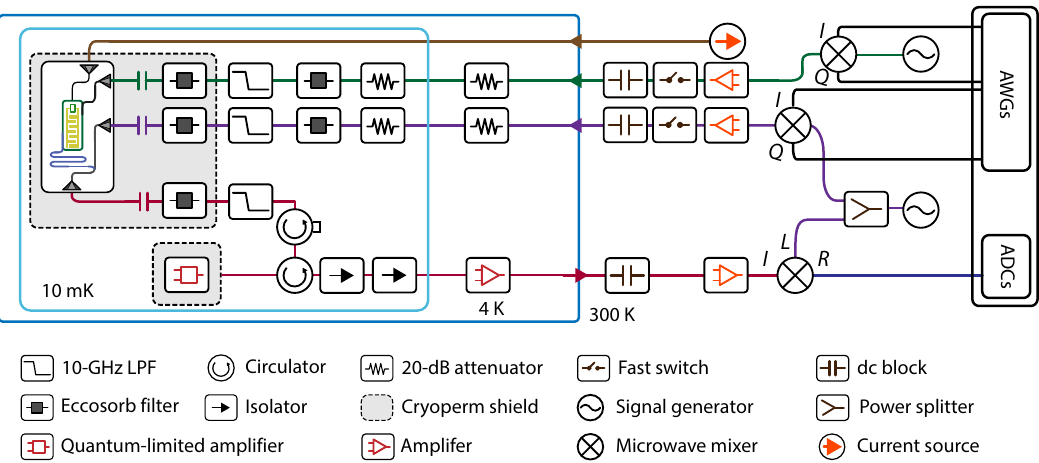
FIG. 8. A typical microwave signal processing chain for a flux-tunable transmon coupled to a readout resonator. The input lines (green and purple) to the sample are usually wired with 20-dB cryogenic attenuators at both the 4-K and 20-mK stage. This level of attenuation, together with the intrinsic insertion loss incurred along the coaxial cables, ensures that the thermal photons reaching the device are kept below 10 − 3 . Commercial low-pass filters (LPFs) and custom-made Eccosorb filters [144,145] are also introduced to suppress high-frequency noise. The output signal passes through a single Eccosorb filter, located inside the Cryoperm, and a low-loss filter. This typically incurs a < 2 dB insertion loss on the signal, which then travels through two cryogenic circulators that provide -20-dB isolation with an additional 0.3-dB loss. The signal is routed by the two circulators to a quantum-limited amplifier, which is usually tuned to operate at 20 dB gain. Here, we omit the pump line to the quantum amplifier. The amplified microwave signals then pass through one or two isolators to the 4-K stage where they are further amplified by a wideband HEMT amplifier before exiting the fridge to the room-temperature signal-processing elements. At room temperature, the drive signals to the transmon and resonator are generated by mixing a LO tone from a microwave signal source with DAC outputs from a quantum controller. These signals are then amplified and filtered before traveling to the qubit drive line (green) and the resonator drive line (purple), respectively. The returning signal from the resonator (red) is demodulated by mixing with the same input carrier tone and then sent to the ADC channels on the controller. The flux control is performed via a flux drive line (brown) with a current source. adding cryogenic filters at the 20-mK plate of the